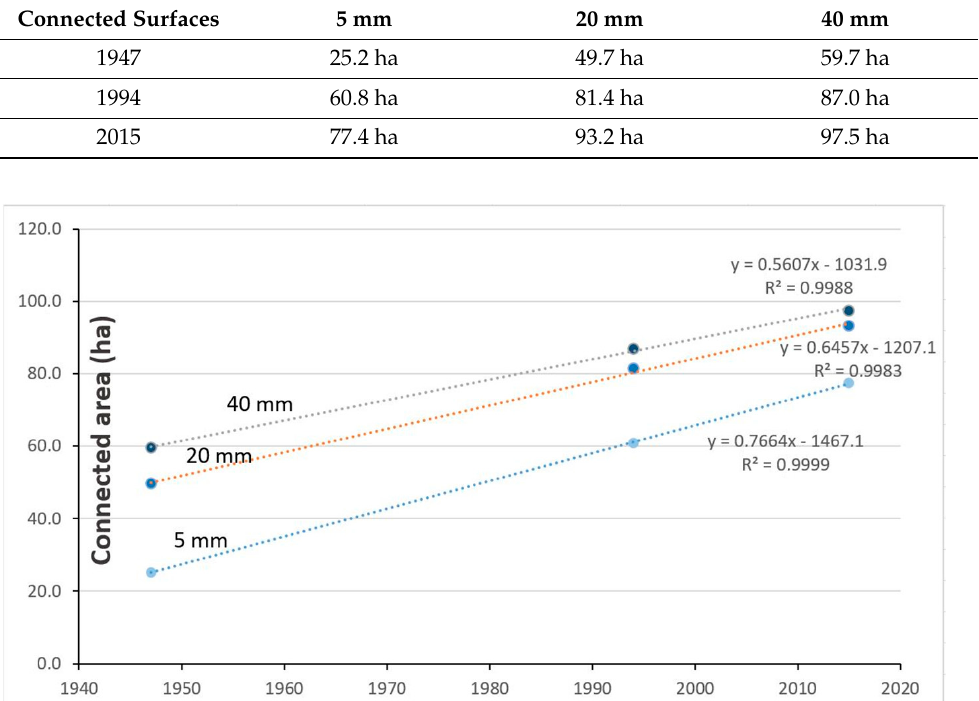
Table 3. Evolution of connected areas.